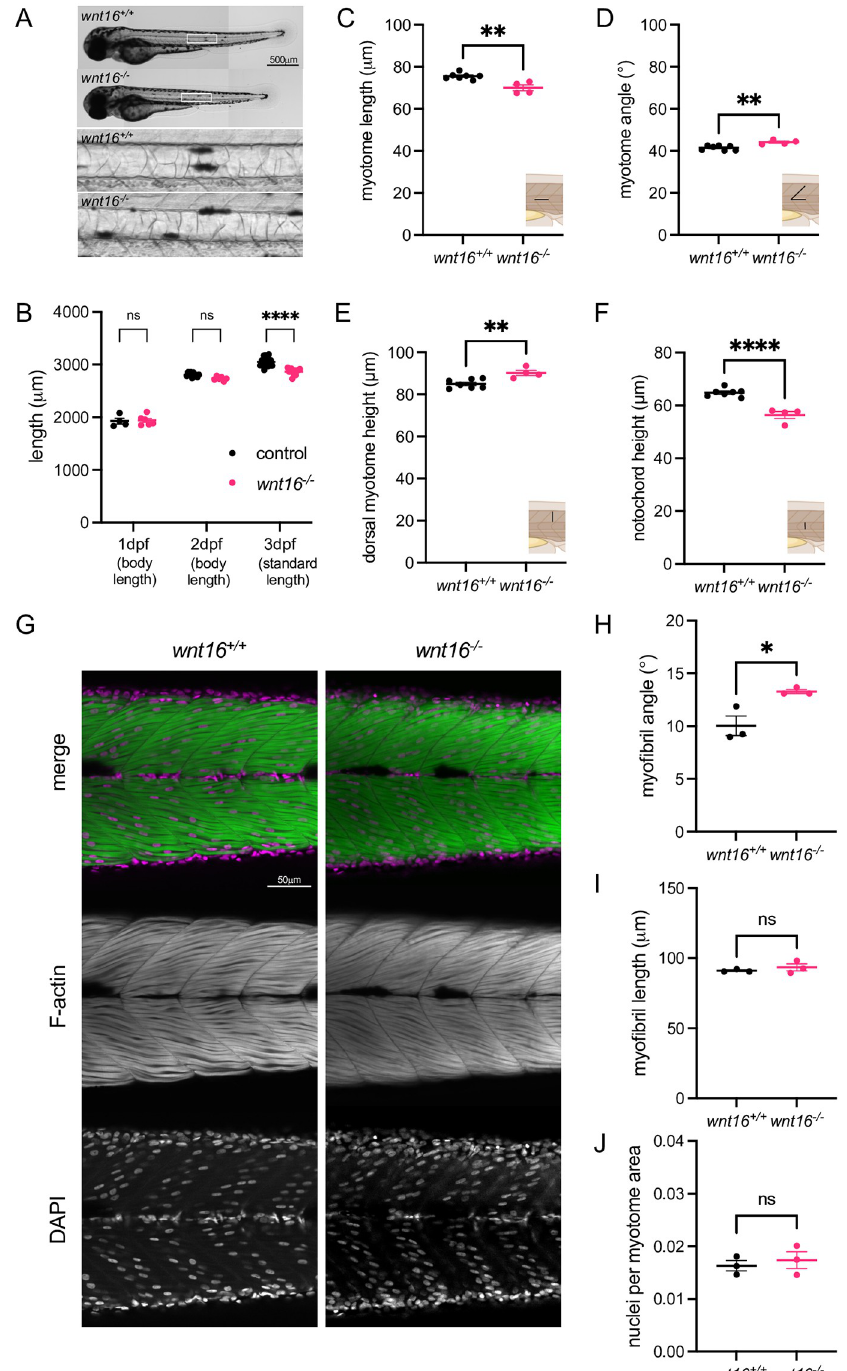
Fig 3. wnt16 is required for notochord and myotome morphogenesis. (A) Brightfield images of wnt16 -/- mutants and clutchmate controls. Insets show closeup of notochord. (B) wnt16 -/- mutants exhibit significantly reduced standard length at 3 dpf. (C-F) Myotome morphology (C-E) and notochord height (F) are altered in wnt16 -/- mutants. Insets provide schematic of measurement. (G) Lateral views of phalloidin-stained 3dpf animals obtained using confocal microscopy. (H-I) Quantitative image analysis reveals that myofibril angle (H) but not myofibril length (I) or nuclei per myotome area (J) are altered in wnt16 -/- mutants. P-values were determined using either two-way ANOVA with Fisher’s LSD post hoc test (B) or an unpaired t-test (C-F, H-J). � p < 0.05, �� p < 0.01, ���� p < 0.0001, ns: not significant.